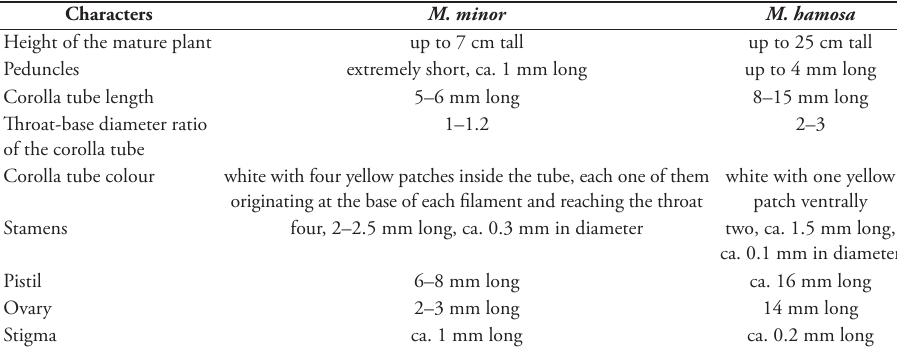
Table 1. Detailed comparison of Microchirita minor and its relative M. hamosa